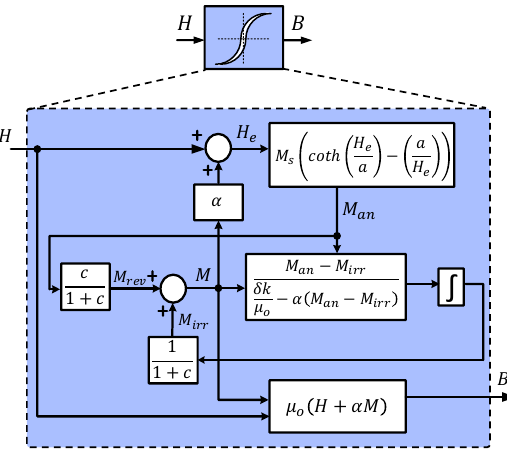
Figure 3. Schematic of the implementation of the Jiles-Atherton (JA) model.